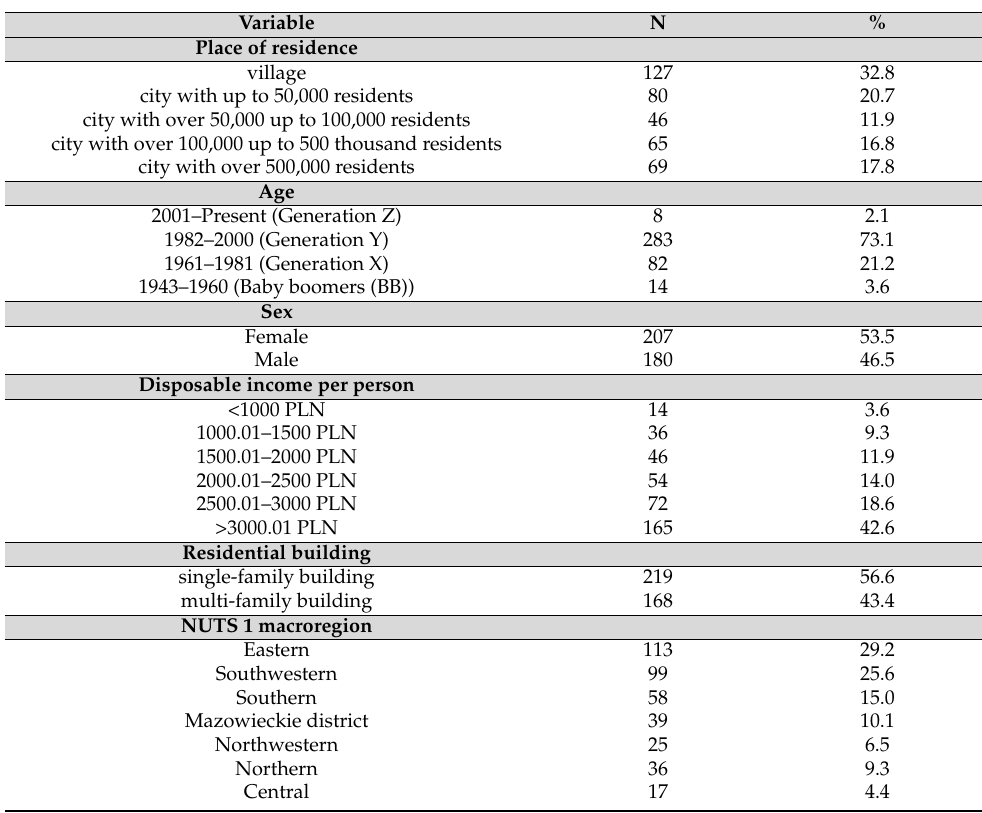
Table 2. Sample characteristics.